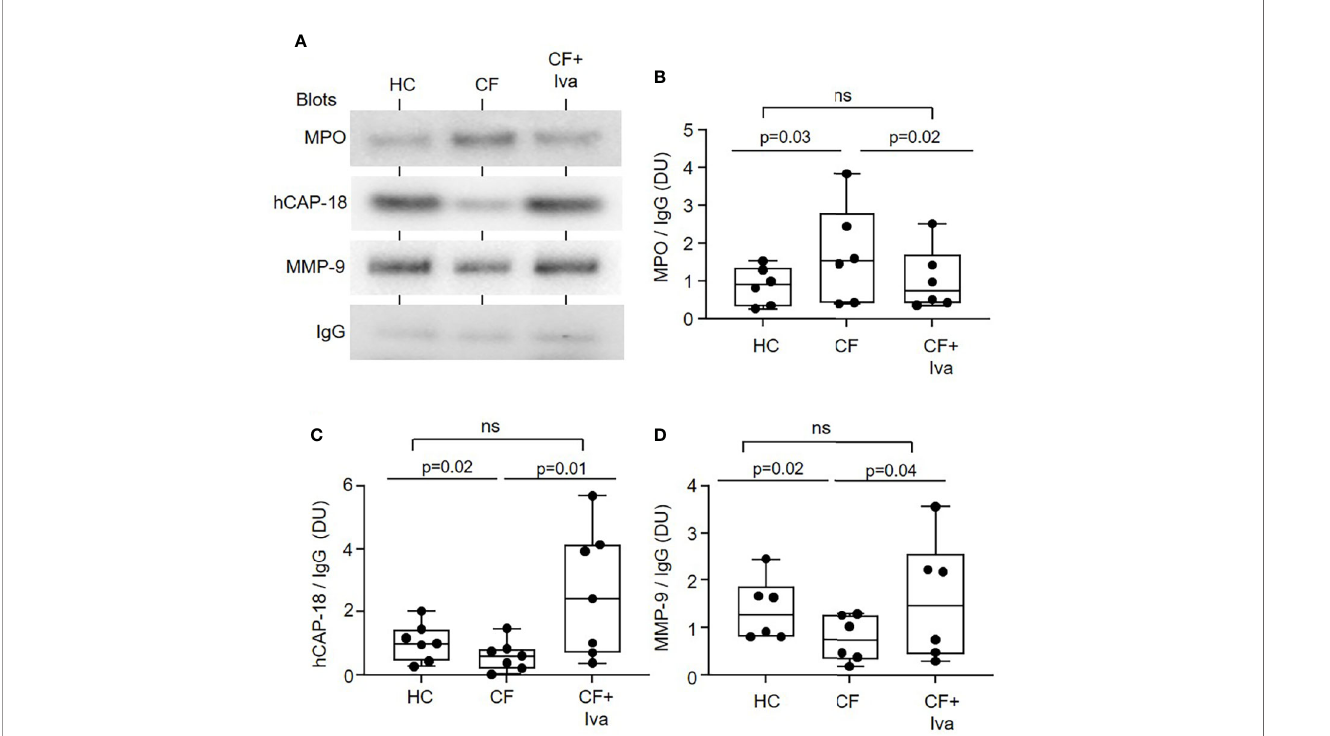
FIGURE 3 | Altered levels of granular proteins in phagosomes of neutrophils from PWCF. (A) Puri fi ed phagosomes were lysed and levels of MPO, hCAP-18, or MMP-9, markers of primary, secondary, and tertiary granule degranulation respectively, were assessed by Western blotting. Compared to phagosomes of HC or PWCF with the Gly551Asp genotype receiving ivacaftor therapy (CF+Iva), CF phagosomes ( Phe508del single copy) contained signi fi cantly increased levels of MPO (B) , and decreased levels of hCAP-18 (C) and MMP-9 (D) . Levels of MPO, hCAP-18 and MMP-9 were not signi fi cantly different between HC and CF+Iva (n = 6 or 7 subjects per group, mixed effects model with Tukeys ’ post hoc test). The opsonin IgG was found equally expressed between the different phagosome types and was therefore used as evidence of equal phagocytosis and as a loading control. Band intensity for MPO, hCAP-18, and MMP-9 was quanti fi ed by densitometry [expressed as densitometry units (DU)] and normalized to